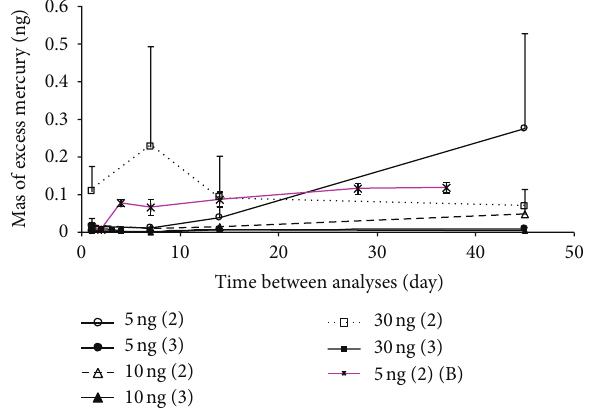
Figure 5: Results of long-term Exp (Exp. no. 4). Amount (ng) of excess mercury measured from the two consecutive blank (the second and third) analyses of adsorption tubes originally loaded with three different amount of mercury (5, 10, and 30 ng). For every standard concentration injection, time gap between first and other (second and third) heating cycles was 1 to 45 days. Each measurement point is the average value of triplicate tube analyses, and a total of nine tubes were used for this analysis. Error bars represent standard deviation of each point (only showing the positive direction). 5ng (2) (B) represents observation from the second heating cycle in our previous investigation